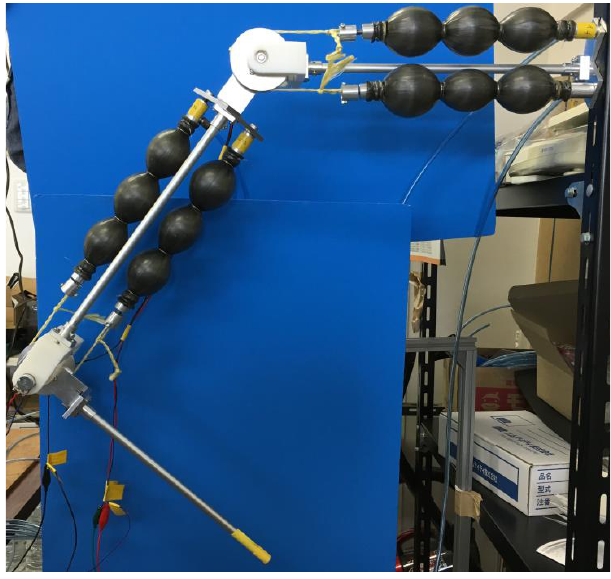
Figure 3. The two-DOF robot leg with pneumatic rubber artificial muscles (PAMs).